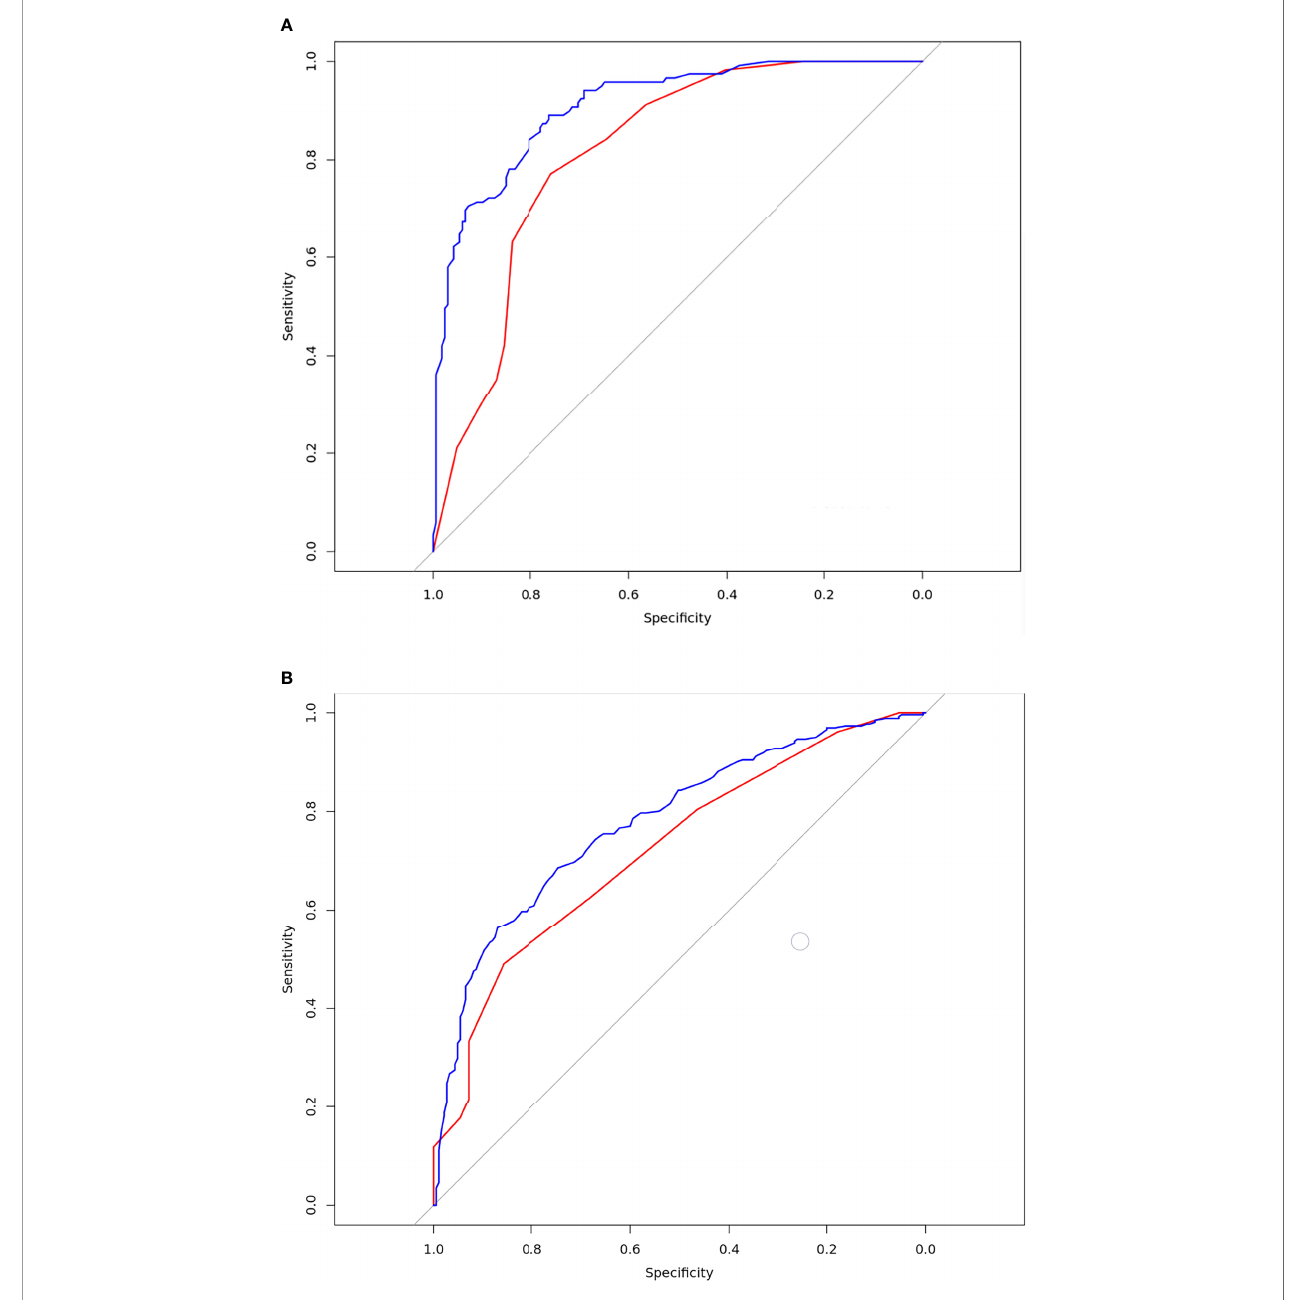
FIGURE 3 | Results of the receiver-operating characteristic curve analysis for the two models. (A) The ROC curves for the model 1 in the training and validation database. The blue line was training set. the AUC value was 0.91[95% con fi dence intervals (CI):0.88-0.94]; the red line was validation set. The AUC value was 0.82 [CI:0.74-0.89];Delong test p=0.0296; (B) The ROC curves for the model 2 in the training and validation database; The blue line was training set. The AUC value was 0.78[CI:0.74-0.82]; The red line was validation set. The AUC value was 0.72[CI:0.63-0.82];Delong test